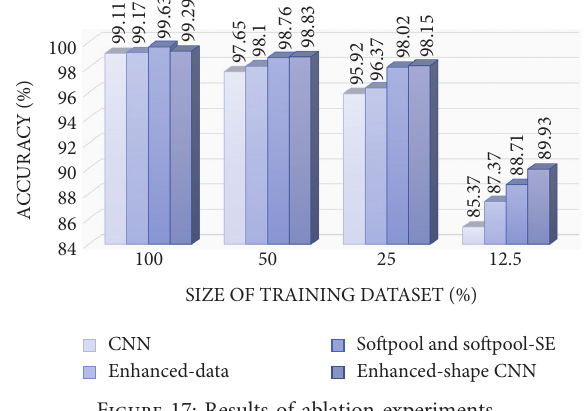
Figure 17: Results of ablation